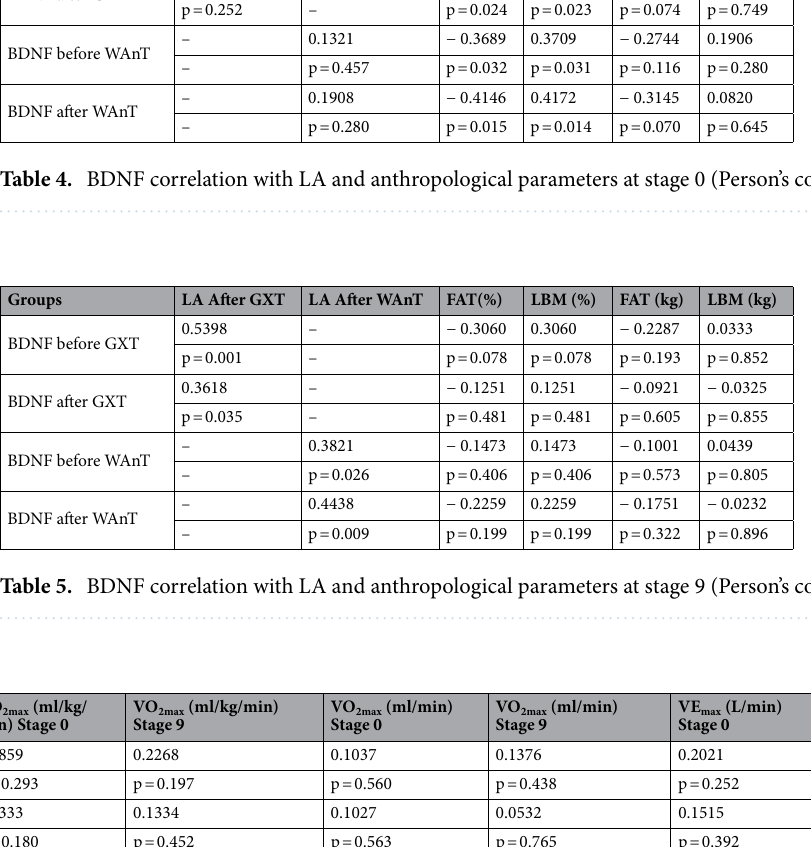
Table 6. Correlation BDNF with VO 2max and VE max measured in GXT parameters at stage 0 and stage 9.